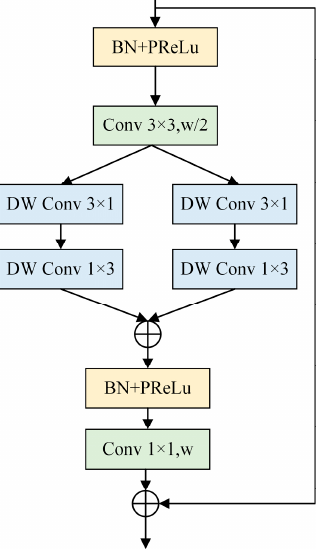
Figure 6. Structure diagram of the DAB module.